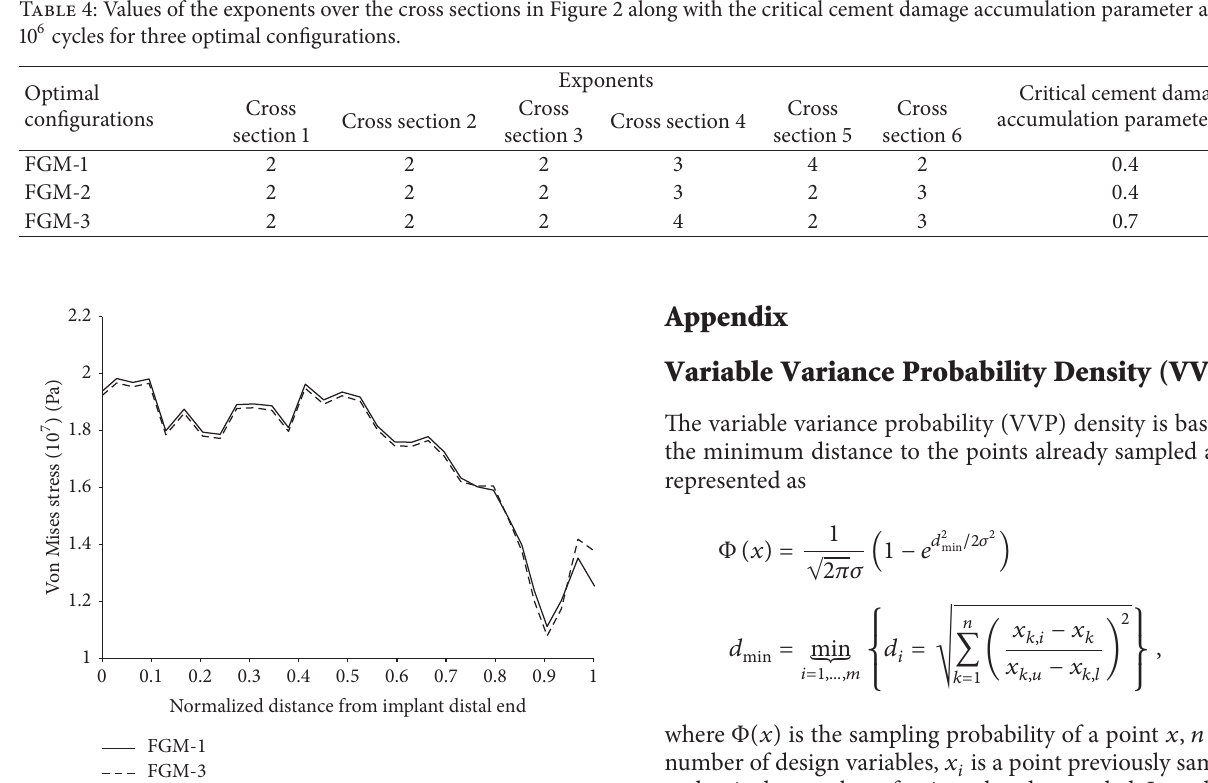
Figure 17: Von Mises stress over the external surface of the